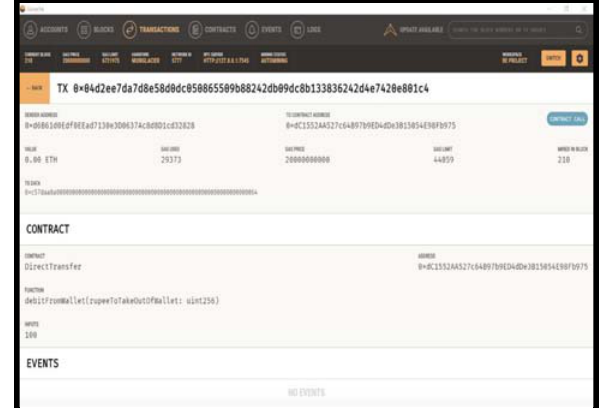
Figure 4. Live Blockchain on Ganache